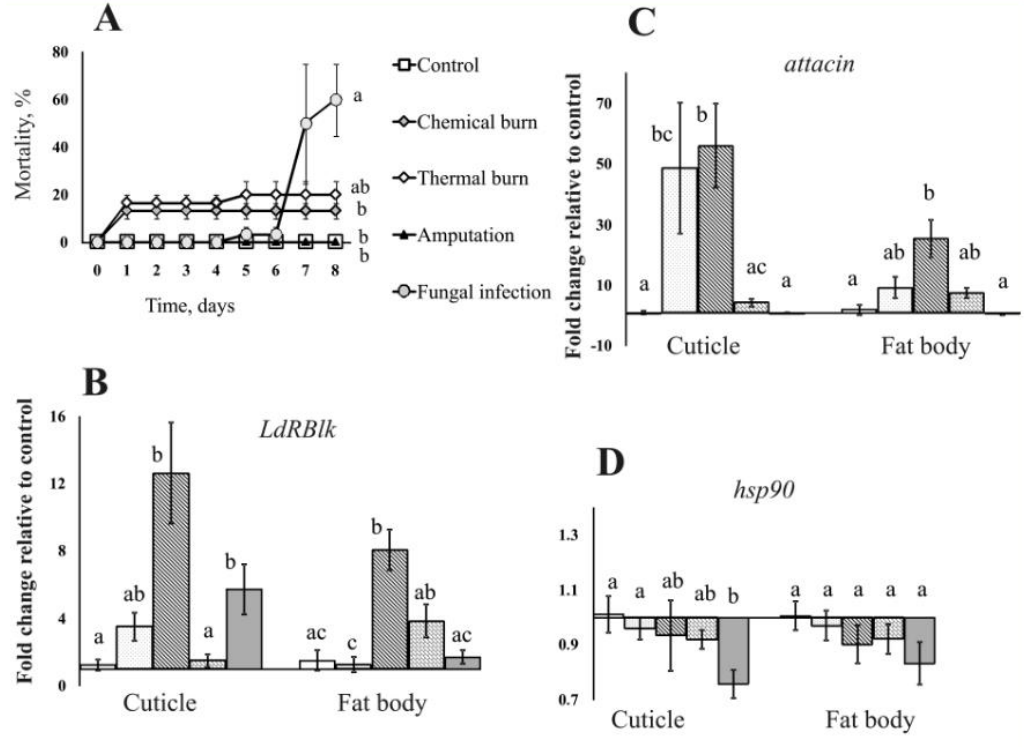
Figure 6. Mortality dynamics ( A ) and changes in the expression of LdRBlk ( B ), attacin ( C ) and hsp90 ( D ) in the cuticle and fat body of Colorado potato beetle larvae after topical injuries of cuticle and topical treatment by fungal suspension (5 µ L). The expression was measured at 24 h after treatments. Data normalized to reference genes: ribosomal proteins L4 and L18 ( Rp4 and Rp18 ) and ADP-ribosylation factor 1 ( Arf19 ). The Y -axis shows the fold change relative to uninfected larvae, calculated separately for each tissue. Different letters show significant differences between treatments (log-rank test χ 2 < 10.7, df = 1, p < 0.001 for mortality assay, and Dunn’s test, p < 0.05 for gene